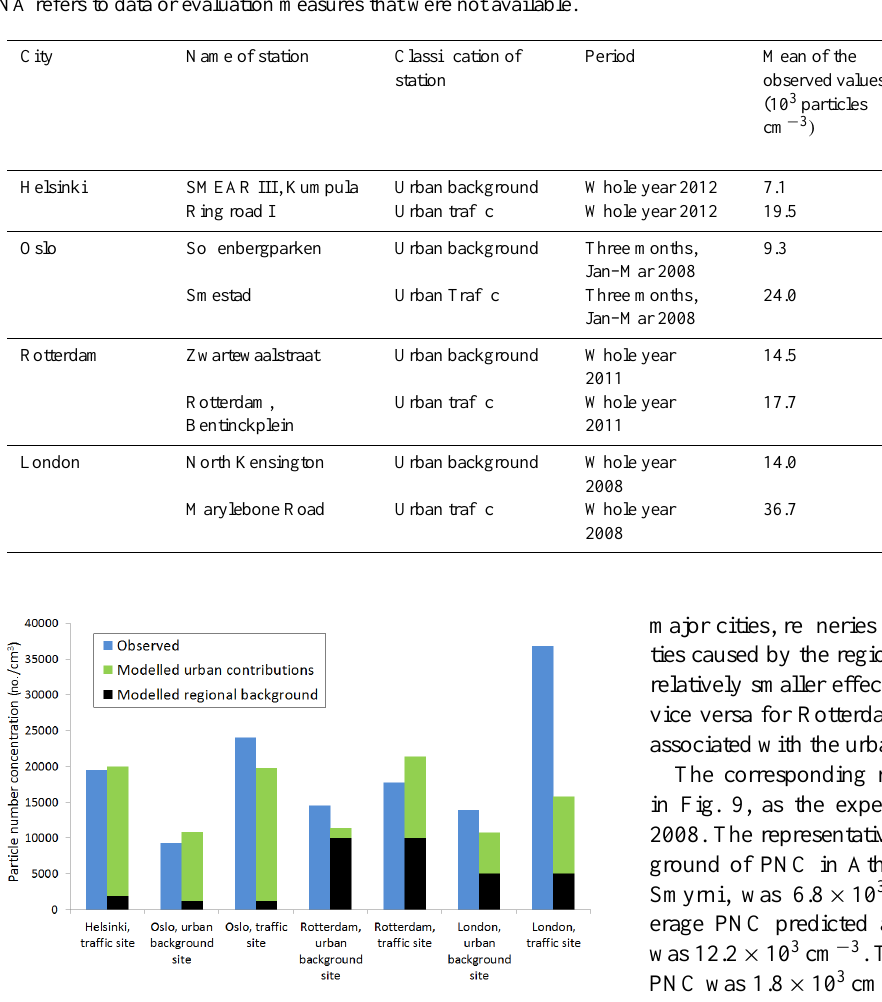
Figure 9. Comparison of the predicted and measured annual aver- age particle number concentrations in four cities. The total predicted concentration is the sum of regional background and urban contri- butions. The names of the stations have been specified in Table